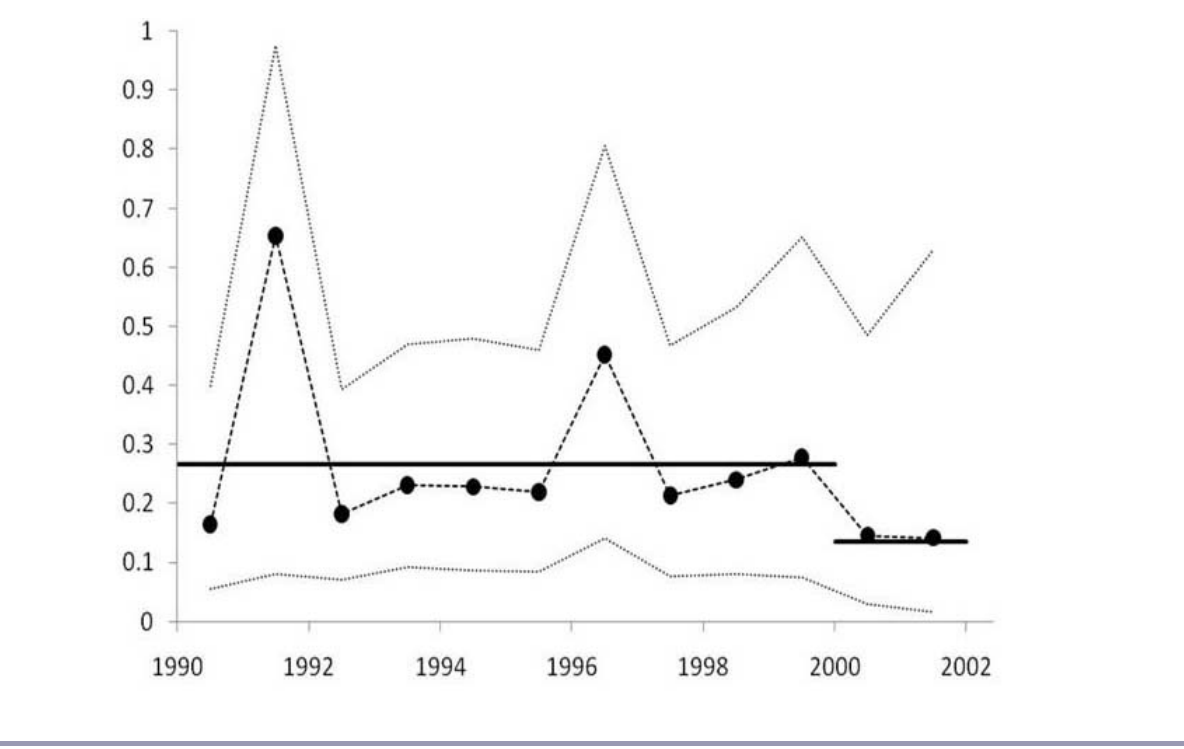
Fig. 5. Average annual apparent survival from chick departure to 3 years of age (dotted lines represent 95% confidence intervals). Solid lines shows the estimated values based on a model with constant survival for periods 1990-2000 and 2000-2003 (95% confidence intervals around survival estimates for periods 1990-2000 and 2000-2003, respectively : [0.23, 0.31] and [0.07,